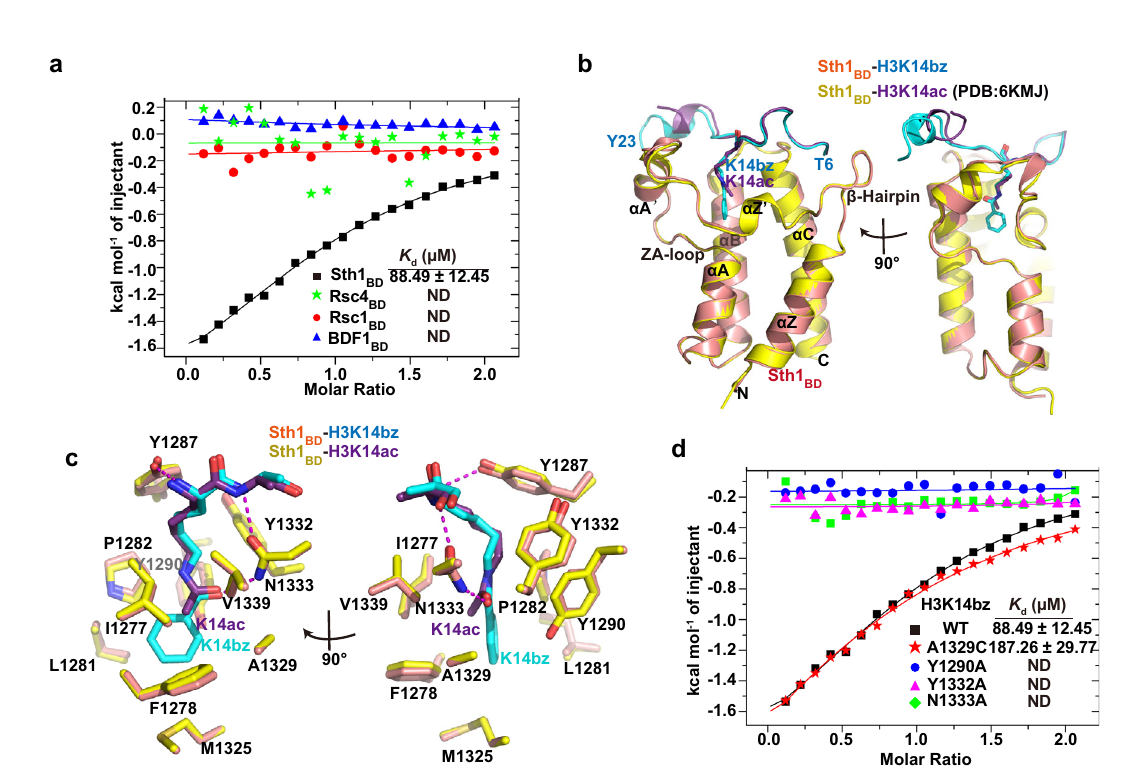
Fig. 6 Sth1 bromodomain has Kbz binding activity. a ITC analyses of four yeast bromodomains binding with H3K14bz peptides. Sth1 BD exhibits a detectable interaction with the H3K14bz peptide ( K d = 89 μ M). b Superimposition of Sth1 BD -H3K14bz (Sth1:orange; H3, cyan) and Sth1 BD -H3K14ac (Sth1: yellow; H3, purple) complexes shows almost identical conformations of Sth1 BD and H3 peptide, except for the C-terminal 3 10 -helix of H3. c Detailed interaction networks between acylated lysine and Sth1 BD . Benzoyl and acetyl groups are shown in cyan and purple, respectively. Hydrophobic contacts and hydrogen-bonding networks are shown. d ITC assays showing the effects of Sth1 mutations on the interaction between Sth1 BD and H3K14bz